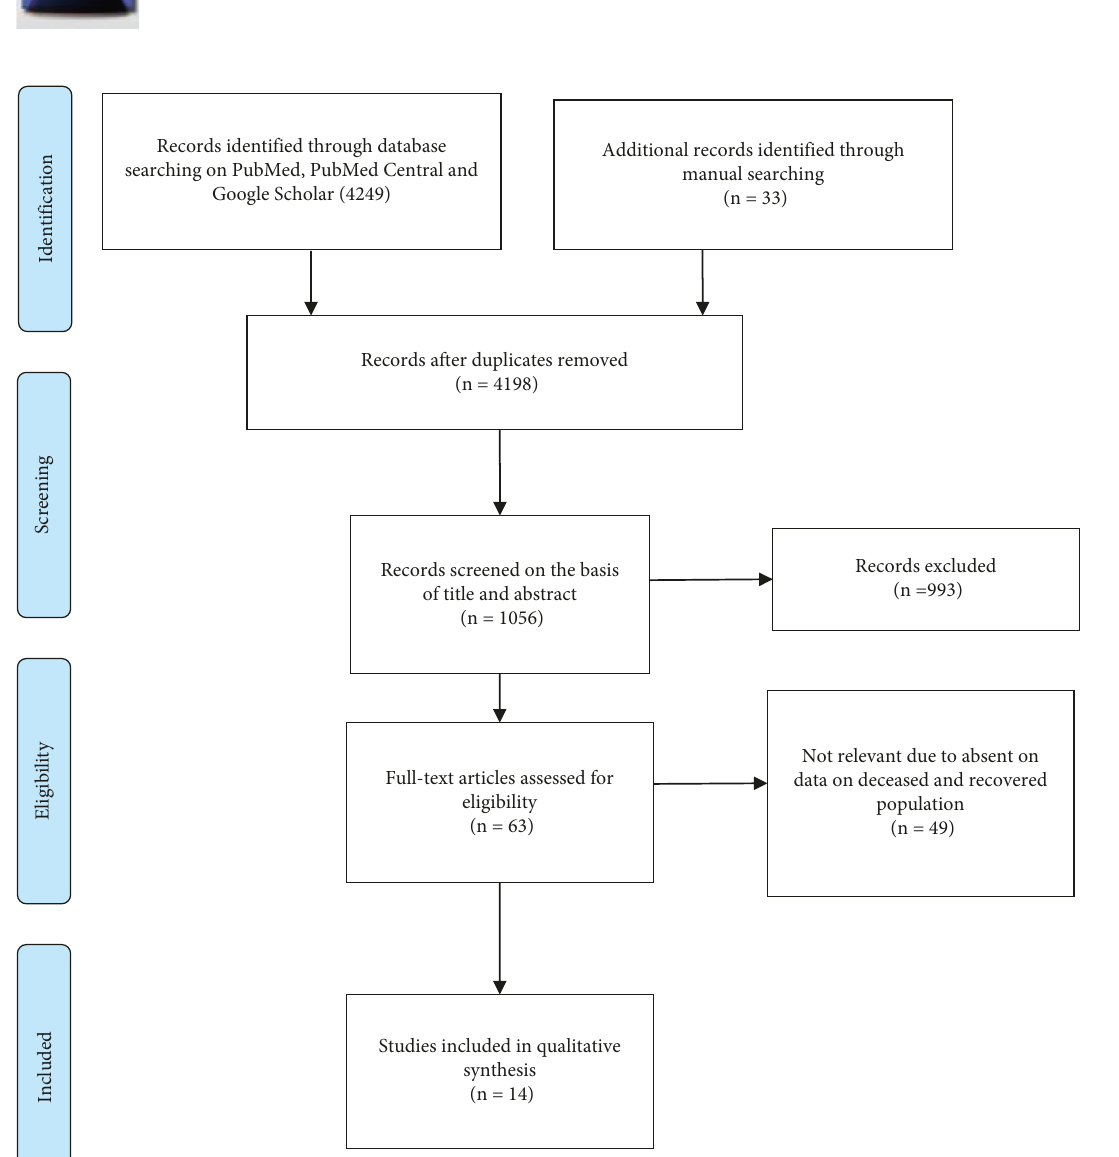
Figure 1: PRISMA flow diagram with flow of information during the systematic